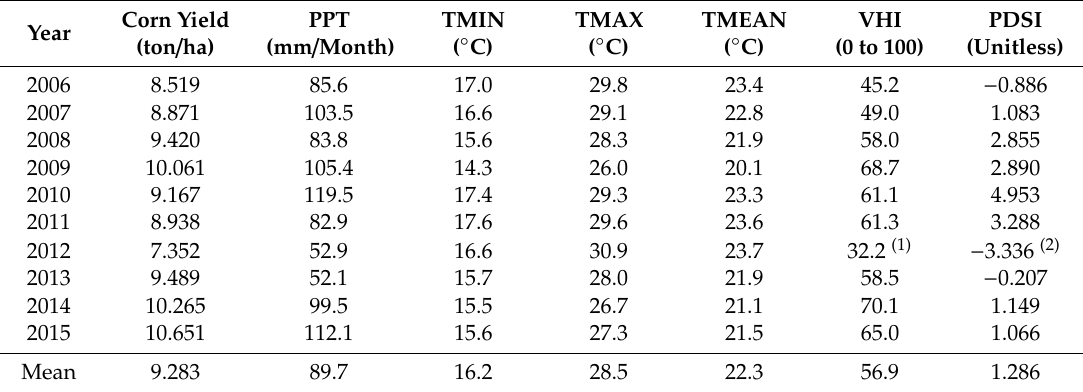
Table 2. Annual corn yield and the precipitation (PPT), minimum air temperature (TMIN), maximum air temperature (TMAX), mean air temperature (TMEAN), Vegetation Health Index (VHI), and Palmer Drought Severity Index (PDSI) for July and August in the study